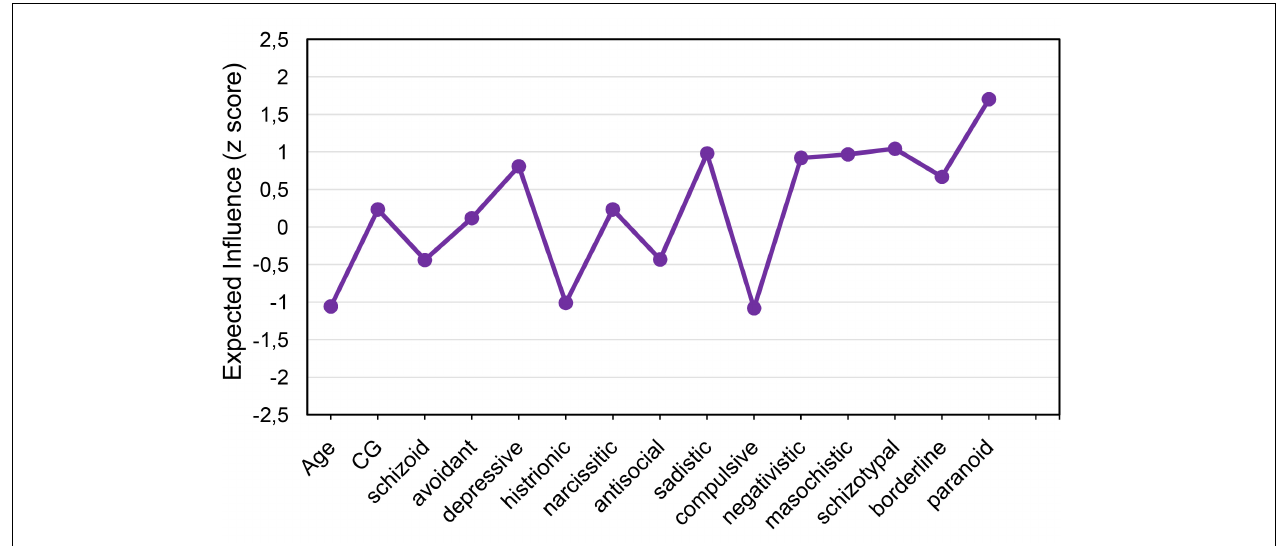
FIGURE 2 | Expected influence for each psychological